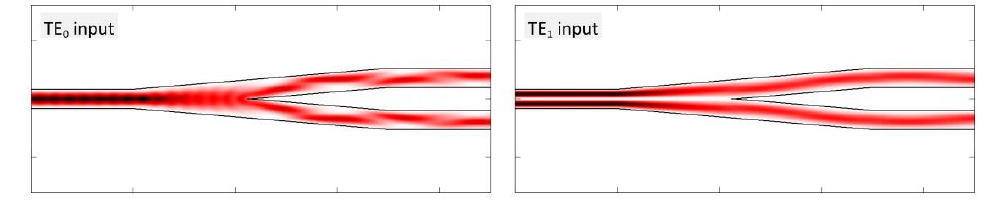
Figure 16. The calculated light propagation profiles for a Y-junction when TE 0 ( left panel ) and TE 1 ( right panel ) are launched. The mode order cannot be preserved in the splitting process. Appl. Sci. 2020 , 10 , x FOR PEER REVIEW 22 of 37